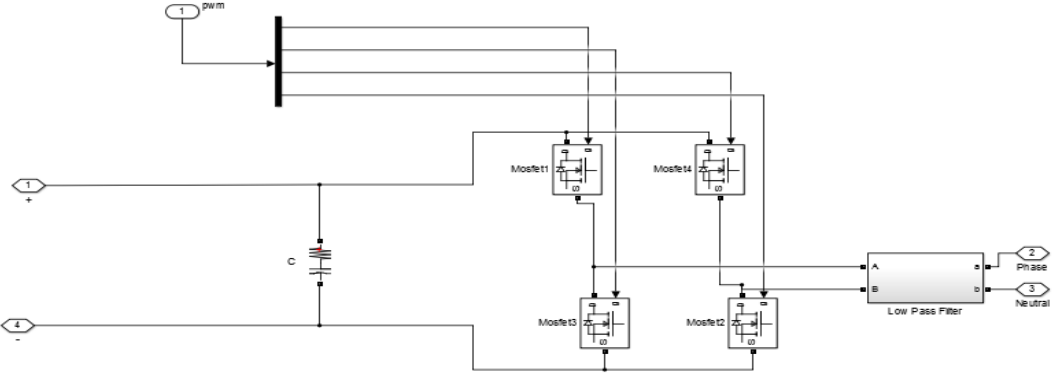
Figure 17. DC-AC inverter using H-Bridge MOSFET and a low pass filter. Table 1. Inverter parameters used in the simulation. Parameters of the Inverter Value Dc grid Voltage 340 VDC